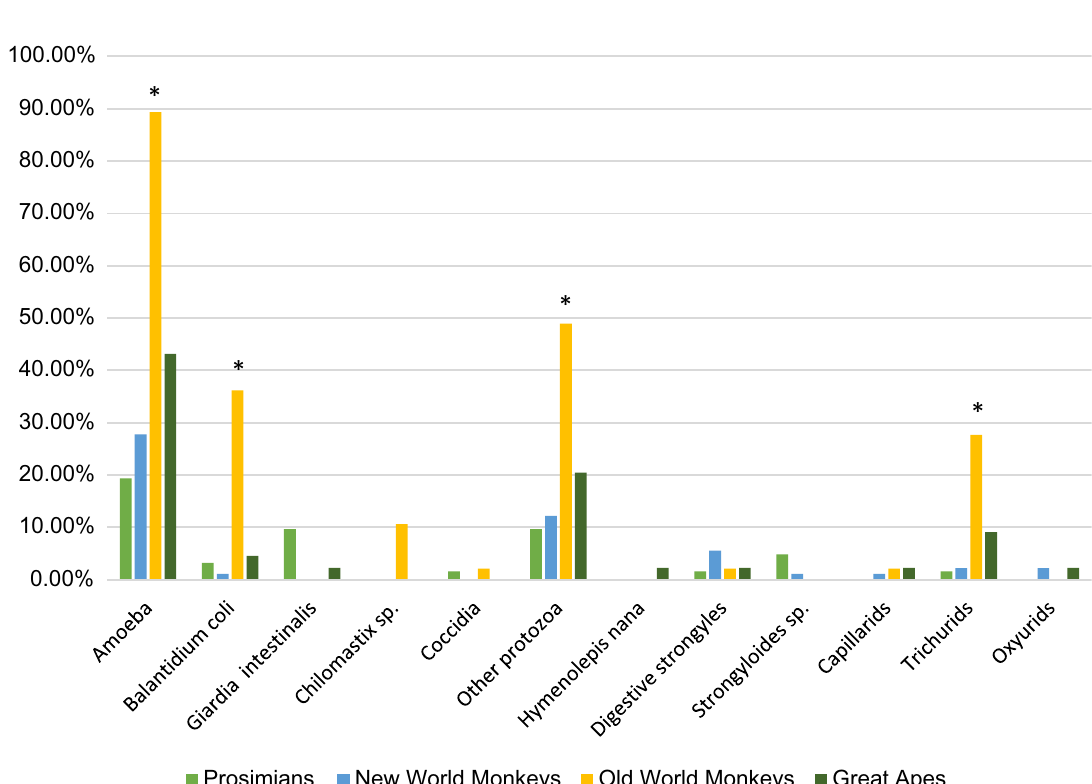
Figure 2. Infection rates of different parasites according to host species group. * Group infection rate signi fi cantly greater than all other groups for the parasite of interest ( p <